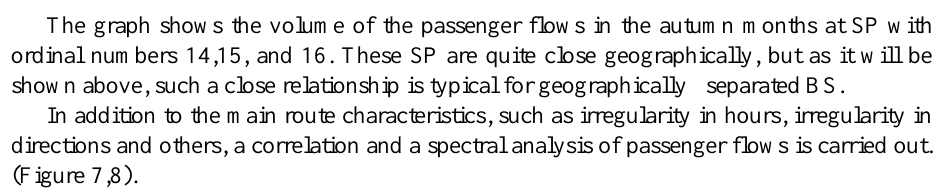
Fig. 6. A temporary series of passenger flows of bus route